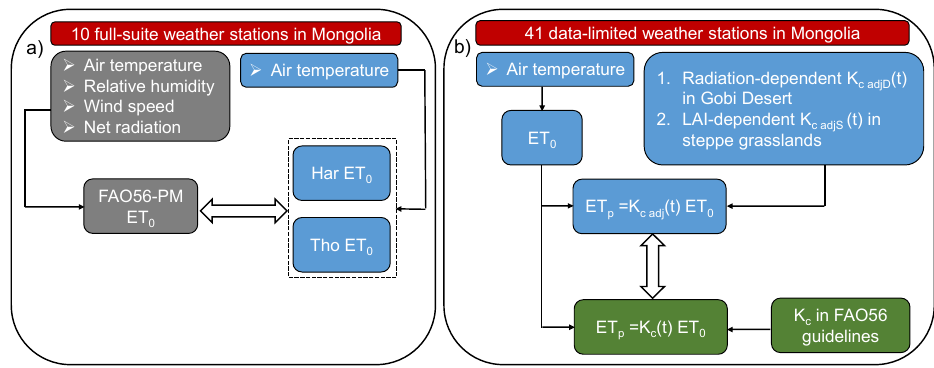
Figure 2. Schematic overview for estimating ( a ) grass-reference potential evapotranspiration, ET 0 derived from FAO-56 PM (gray boxes) and temperature-based equations, Har and Tho (blue boxes), using data from 10 weather stations (garnet boxes); and ( b ) biome-specific potential evapotranspiration, ET p , derived from K c tabulated in the FAO-56 guidelines (green boxes) and from a new K c adj (blue boxes) using data from 41 weather stations (garnet boxes). The new crop coefficient, K c adj depends on net solar radiation in the Gobi Desert ( K c adjD ) or ( b ) leaf area index in the steppe region ( K c adjS ).